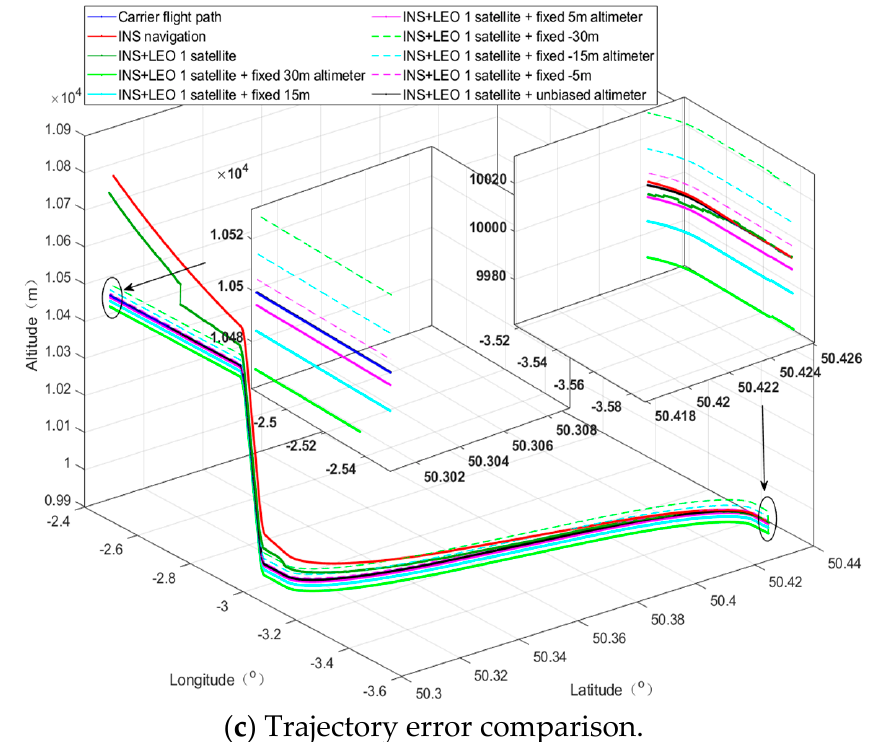
Figure 7. Single-satellite navigation and positioning results in altimeter scenes. Table 7. Trajectory error